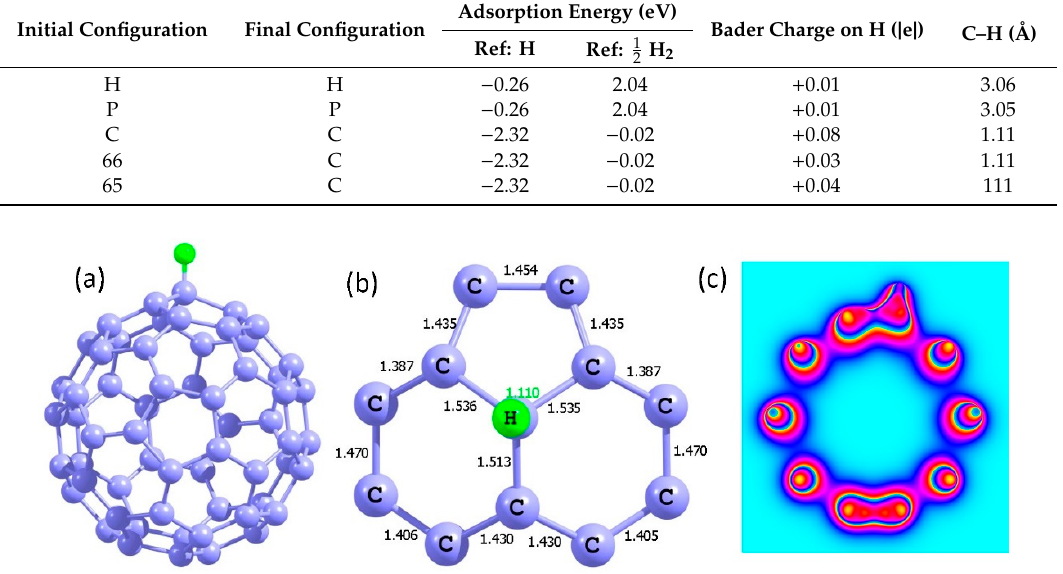
Figure 2. ( a ) Optimized structure of a single hydrogen atom adsorbed on the “C” site, ( b ) bond distances and ( c ) charge density plot showing the strong bonding nature of hydrogen with C atom on the surface.